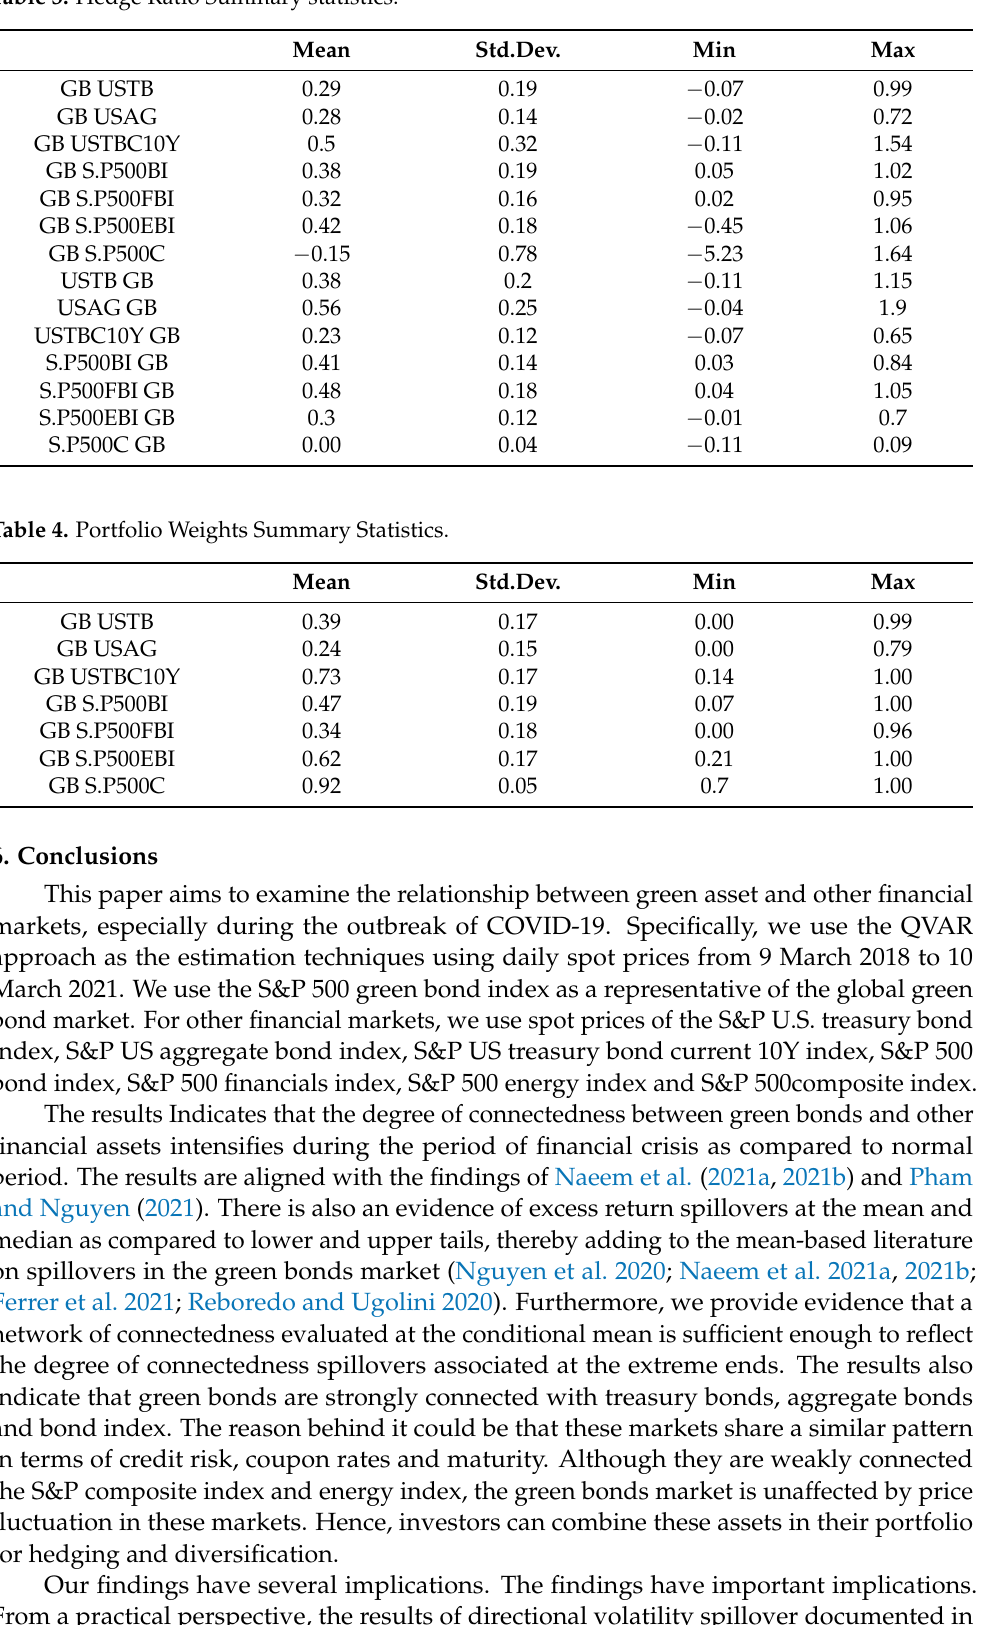
Table 3. Hedge Ratio Summary statistics.